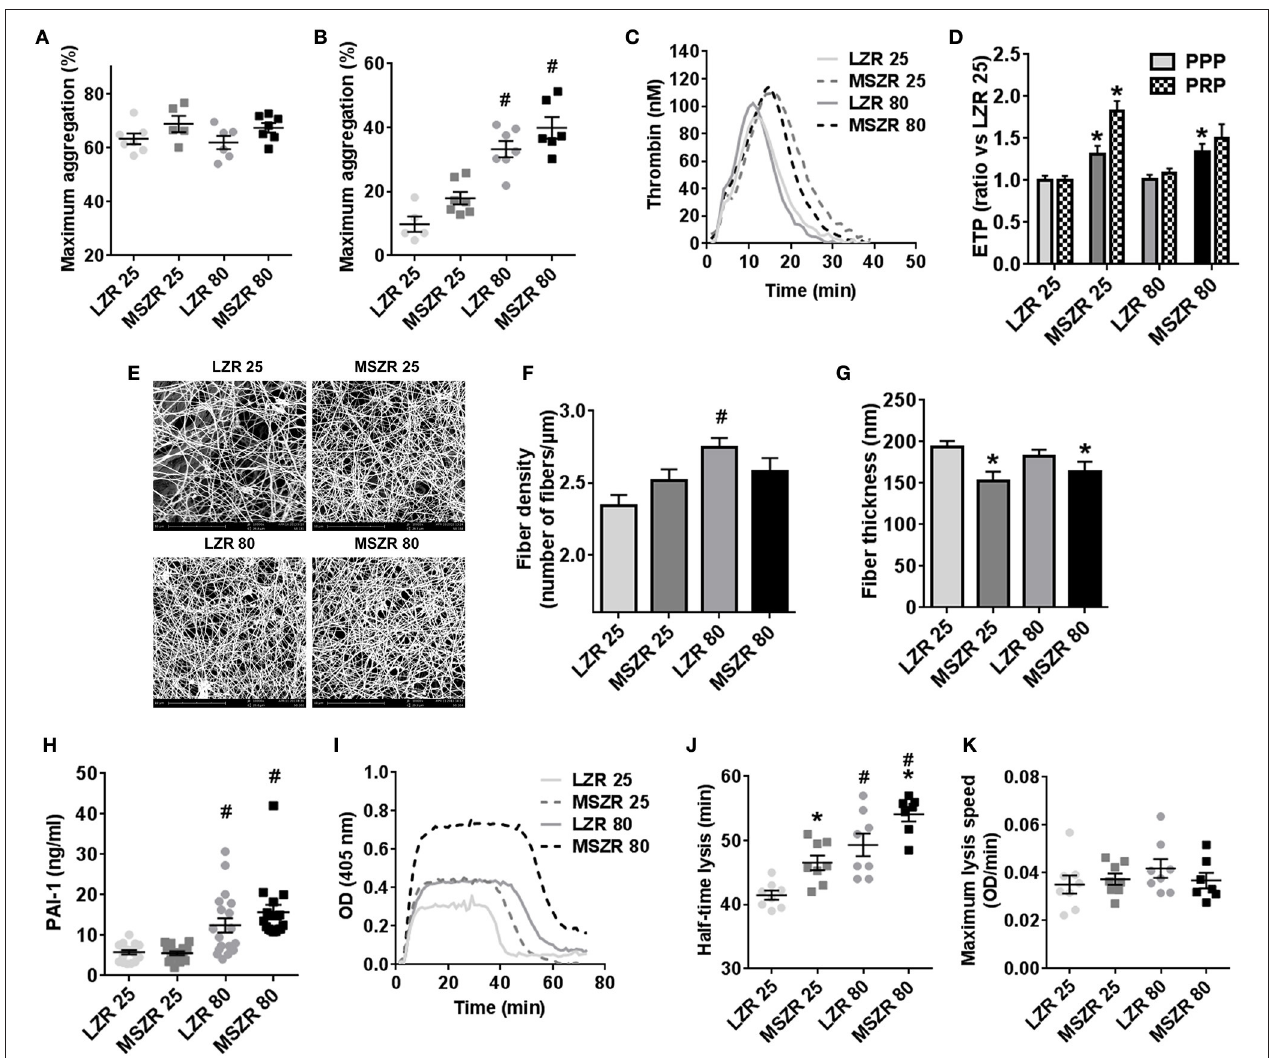
FIGURE 1 | Platelet aggregation, thrombin generation, and fibrinolysis in LZR and MSZR rats . (A) Mean maximum aggregation in washed platelets in response to collagen (5 µ g/ml) and in (B) platelet-rich plasma (PRP) in response to ADP (5 µ M), with the platelet count adjusted to 200 × 10 9 platelets/l. (C) Calibrated automated thrombinography (CAT) in rat plasma. Mean thrombin generation curves in platelet free plasma (PFP) triggered by 5 pM tissue factor in LZR and MSZR at 25 and 80 weeks of age. (D) Endogenous thrombin potential (ETP) in PFP and PRP of 25 and 80 week-old LZR and MSZR, expressed as ratios of values for 25 week-old LZR. (E) Ultrastructure of fibrin fibers was visualized by scanning electron microscopy. Pictures were made at 10,000 × magnification. (F,G) Fiber thickness and fiber density of fibrin clot in LZR and MSZR. (H) ELISA results of PAI-1 measured in PFP ( n = 17–19). (I) Representative curves of fibrinolytic tests in PFP in LZR and MSZR. (J,K) Half-lysis time and maximal lysis speed of fibrinolytic tests in LZR and MSZR. Results are mean ± standard error of the mean ( n = 7–11). * p < 0.05 vs. LZR at the same age; # p < 0.05 vs. 25 week-old rats in the same